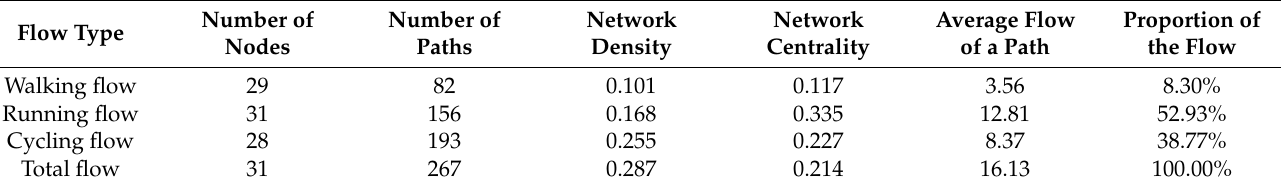
Table 2. Network characteristics under different exercise